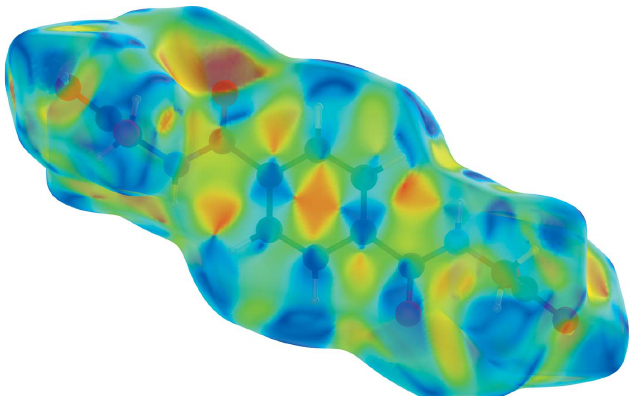
Figure 9 Hirshfeld surfaces drawn with transparency and mapped over the shape- index for the N , N 0 -(1,4-phenylenedicarbonyl)diglycine solvent molecule. Red and blue triangles indicate the region involved in (cid:2) – (cid:2) stacking interactions.